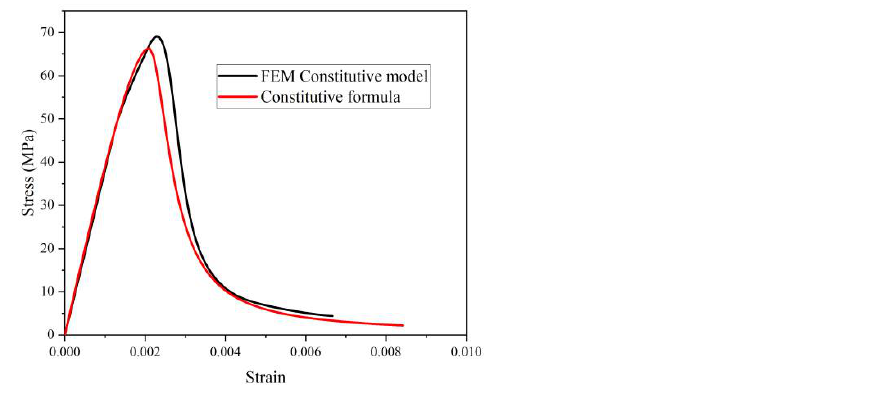
Figure 4. Comparison of stress-strain curves of high strength grouting material under compression.